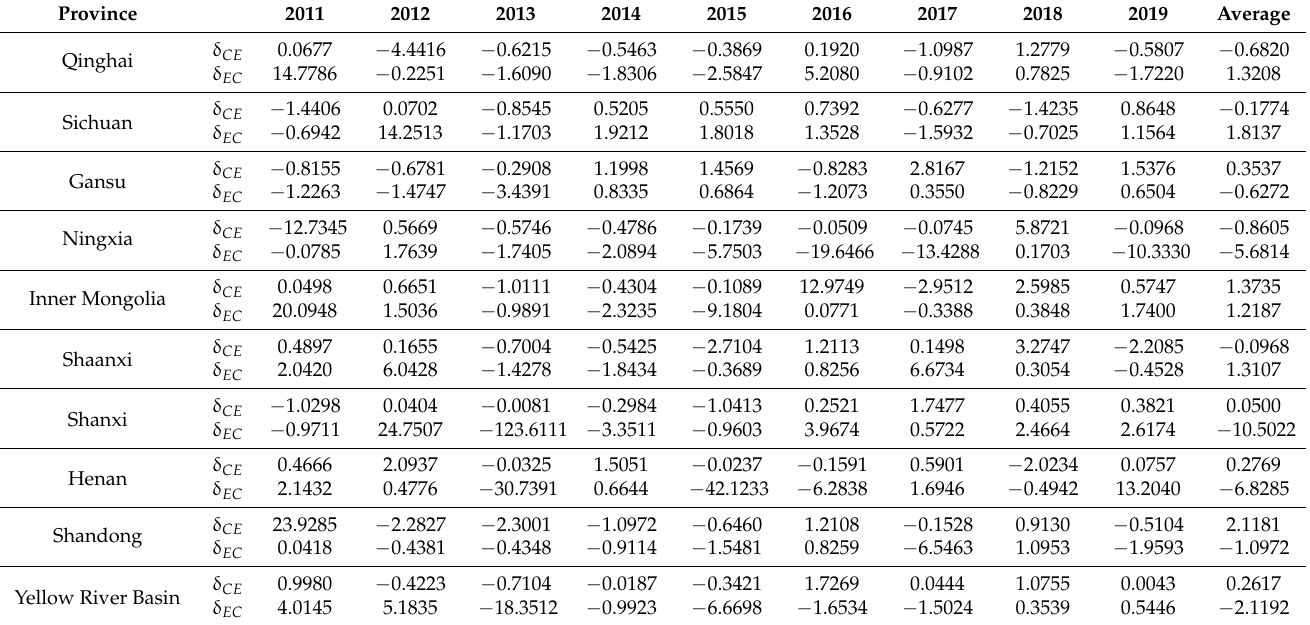
Table 7. Symbiosis between tourism’s carbon emission efficiency (TCEE) and the tourism economy’s high-quality development